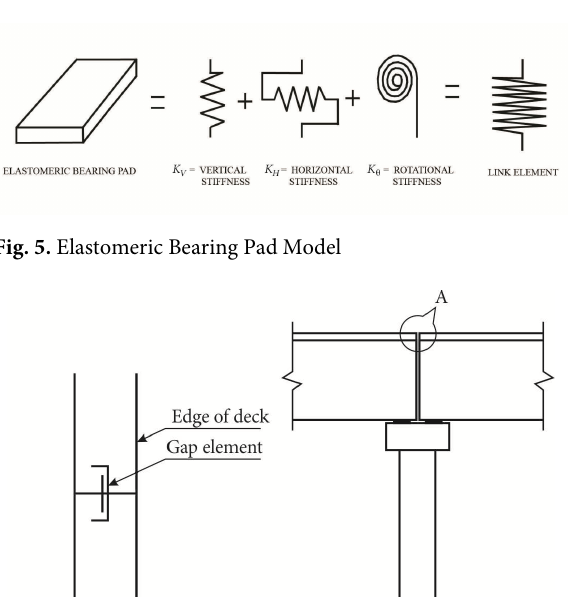
Fig. 4. SAP2000 FEM of the study bridge